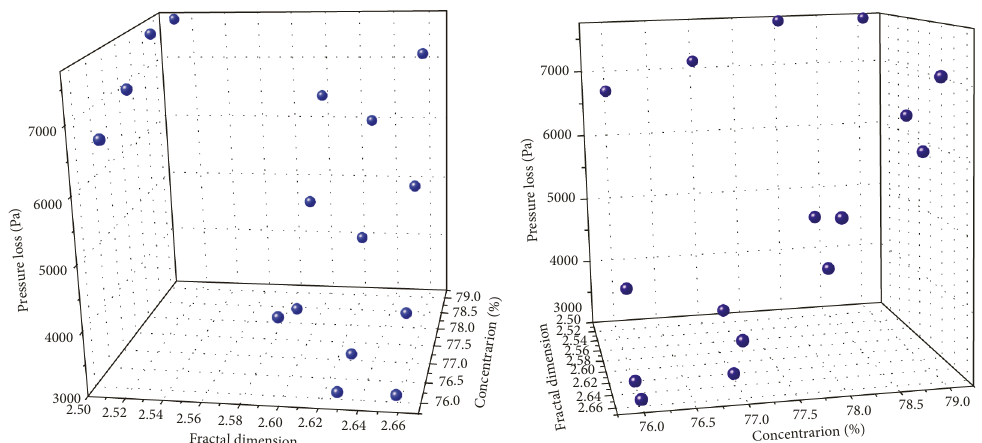
Figure 11: Average pressure loss per unit length of different